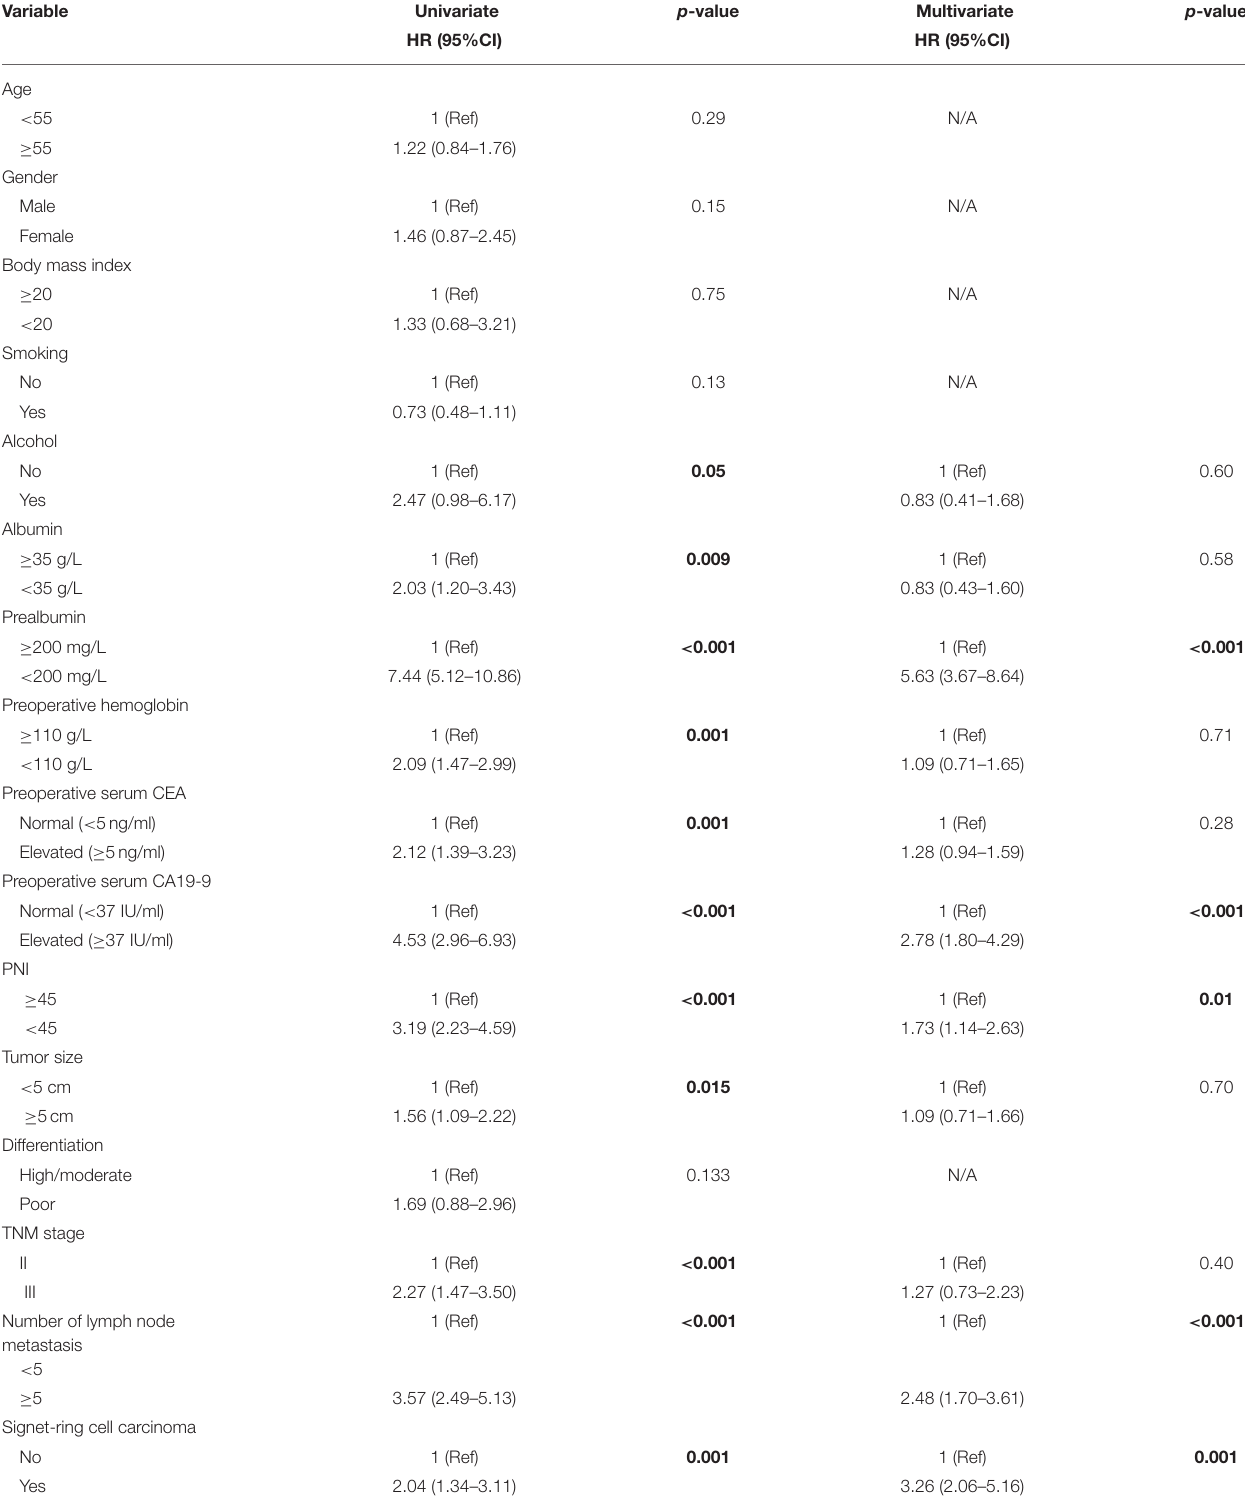
TABLE 4 | Univariate and multivariate logistic regression analyses of factors associated with recurrence in gastric cancer patients ( n = 462).